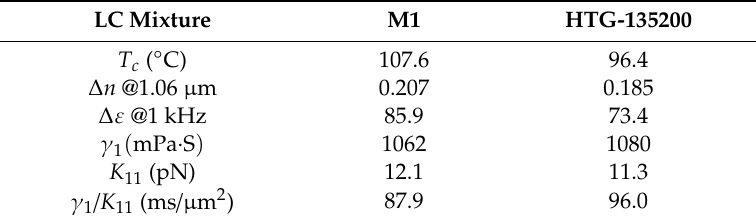
Table 1. Measured physical properties of M1 and HTG-135200 (HTG) at T = 25 ◦